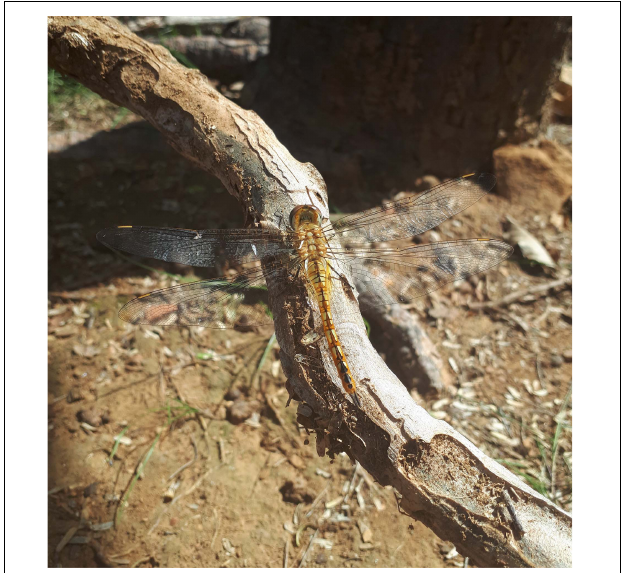
FIGURE 1 | Globe skimmer ( Pantala flavescens ). Photo by: Johanna Hedlund 2019.